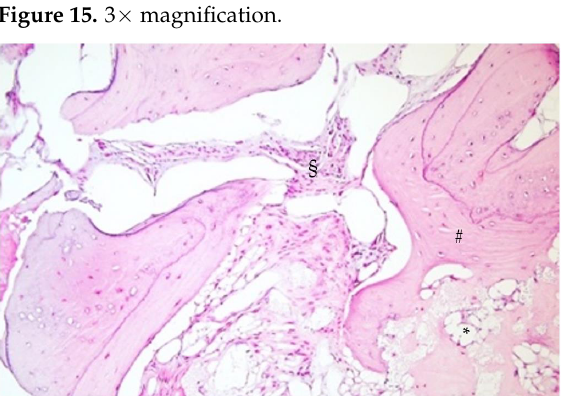
Figure 16. 30× magnification. * Adipose tissue, § medullary bone, # mature